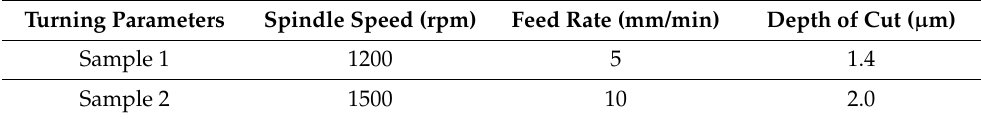
Table 1. Turning parameters of